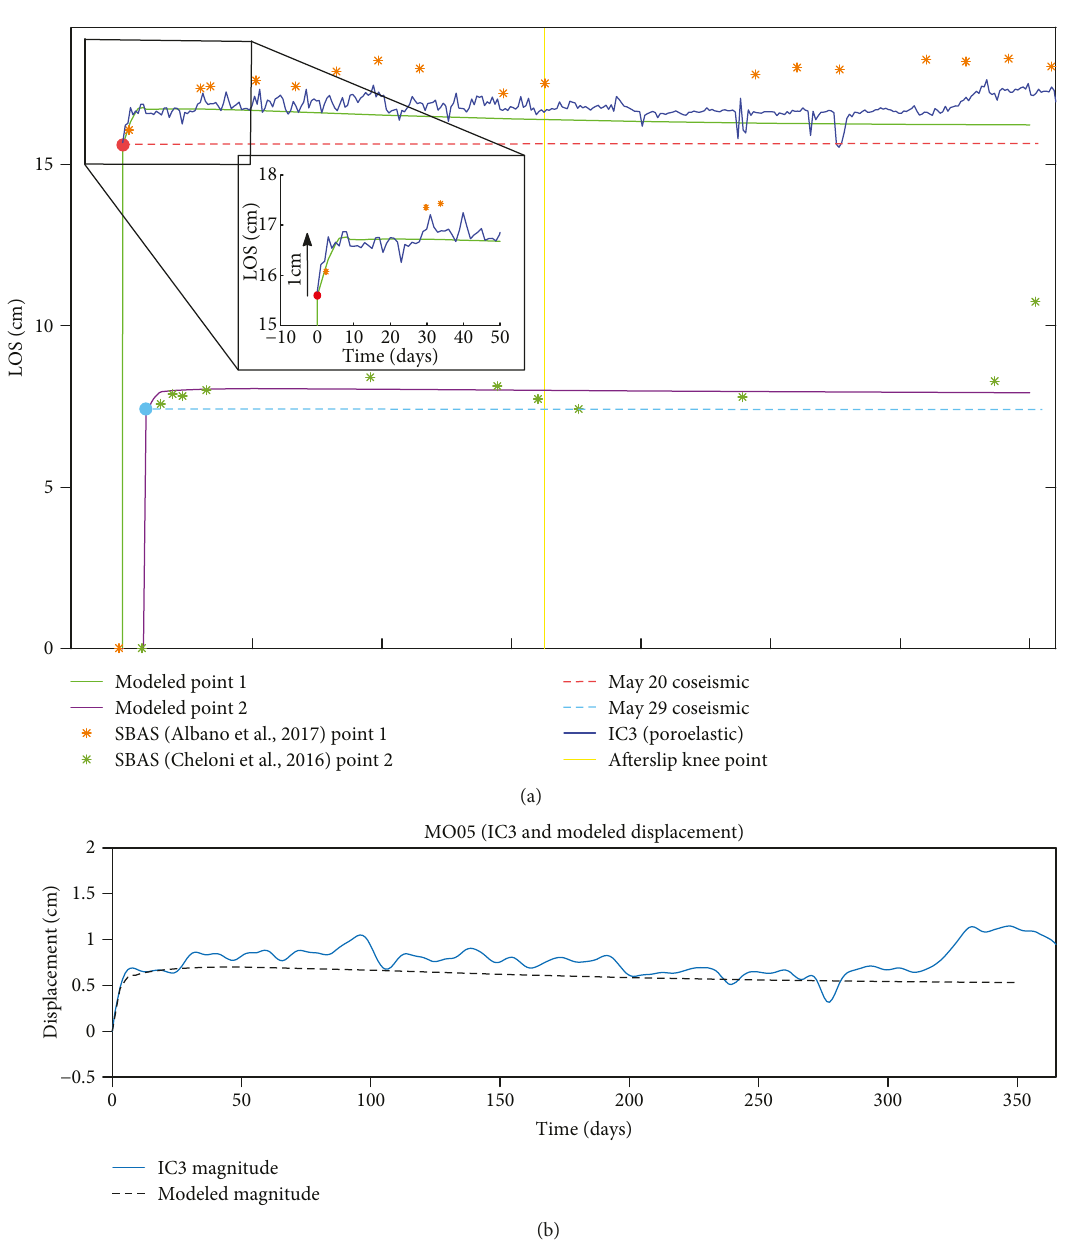
Figure 8: (a) InSAR (SBAS) time series measured at point 1 (orange dots) and at point 2 (dark green dots). The purple and the light blue circles represent the coseismic displacement of the May 20 and May 29 mainshocks, respectively, obtained by our model. The green and purple lines represent the modeled poroelastic deformation at point 1 and point 2, respectively (Figure 1). The blue line is the IC3 time dependence rescaled to represent the point 1 modeled poroelastic LOS displacement in the fi rst 50 days following the May 20 mainshock (see inset). A 3D line of sight was considered for both the InSAR (SBAS) time series and modeled LOS displacement. (b) Modeled GPS displacement magnitude of station MO05 in S2 (black dashed line) and IC3 displacement magnitude for MO05 station over time (light blue